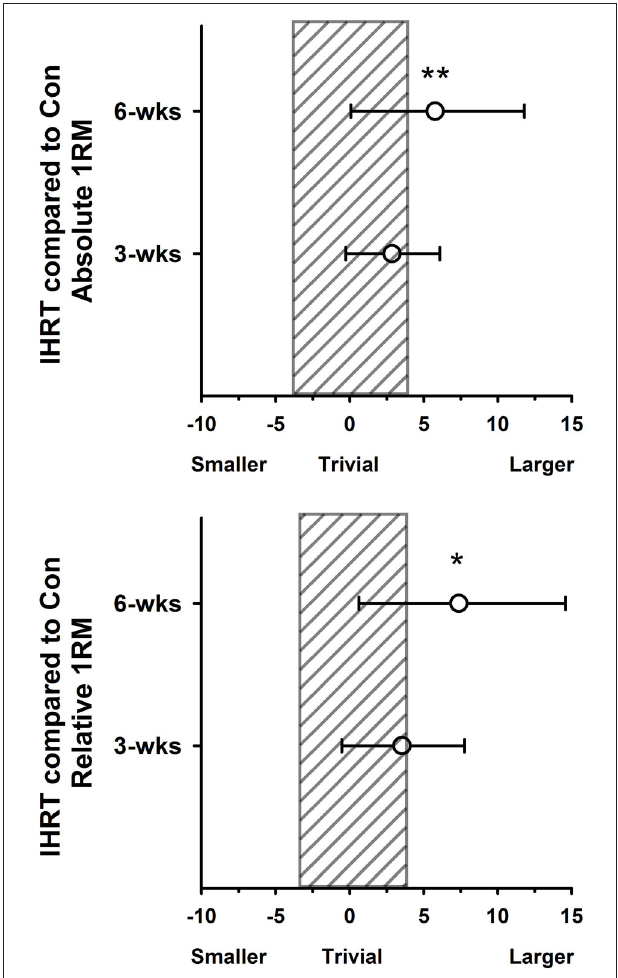
FIGURE 1 | Percentage difference in the change in performance from baseline for intermittent hypoxic resistance training (IHRT) compared with placebo with 90% CI. (A) Between-groups change in Absolute 1RM strength. (B) Between-groups change in Relative 1RM strength. Shaded bar represents uncertainty in the measure. * Possibly small effect in the difference in change between groups, ** Likely small effect in the difference in the change between